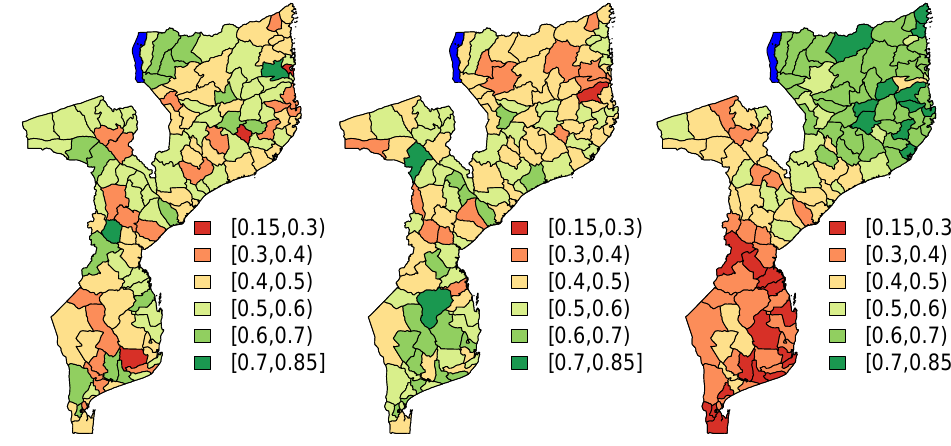
Figure 2. Plot of assumed population proportions P k for scenario ( A 1 ) ( left ), scenario ( A 2 ) ( middle ) and scenario ( A 3 ) ( right